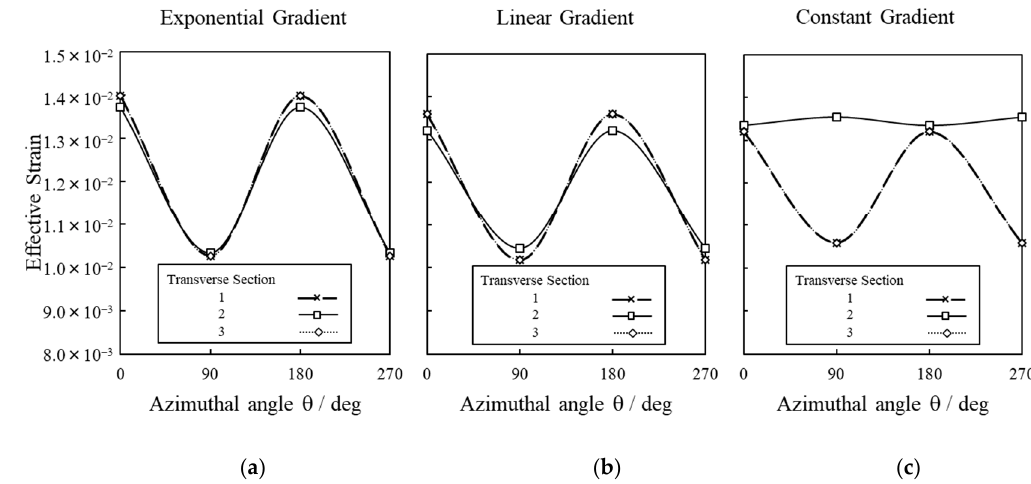
Figure 13. Distribution of effective strain in terms of azimuthal angle, θ at transverse sections 1, 2 and 3 in three types of shrinkage models corresponding to: ( a ) exponential gradient, ( b ) linear gradient and ( c ) constant gradient.